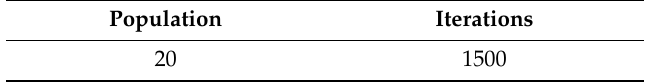
Table 14. Parameters used in FA, WDO, and DSO for fuzzy controller